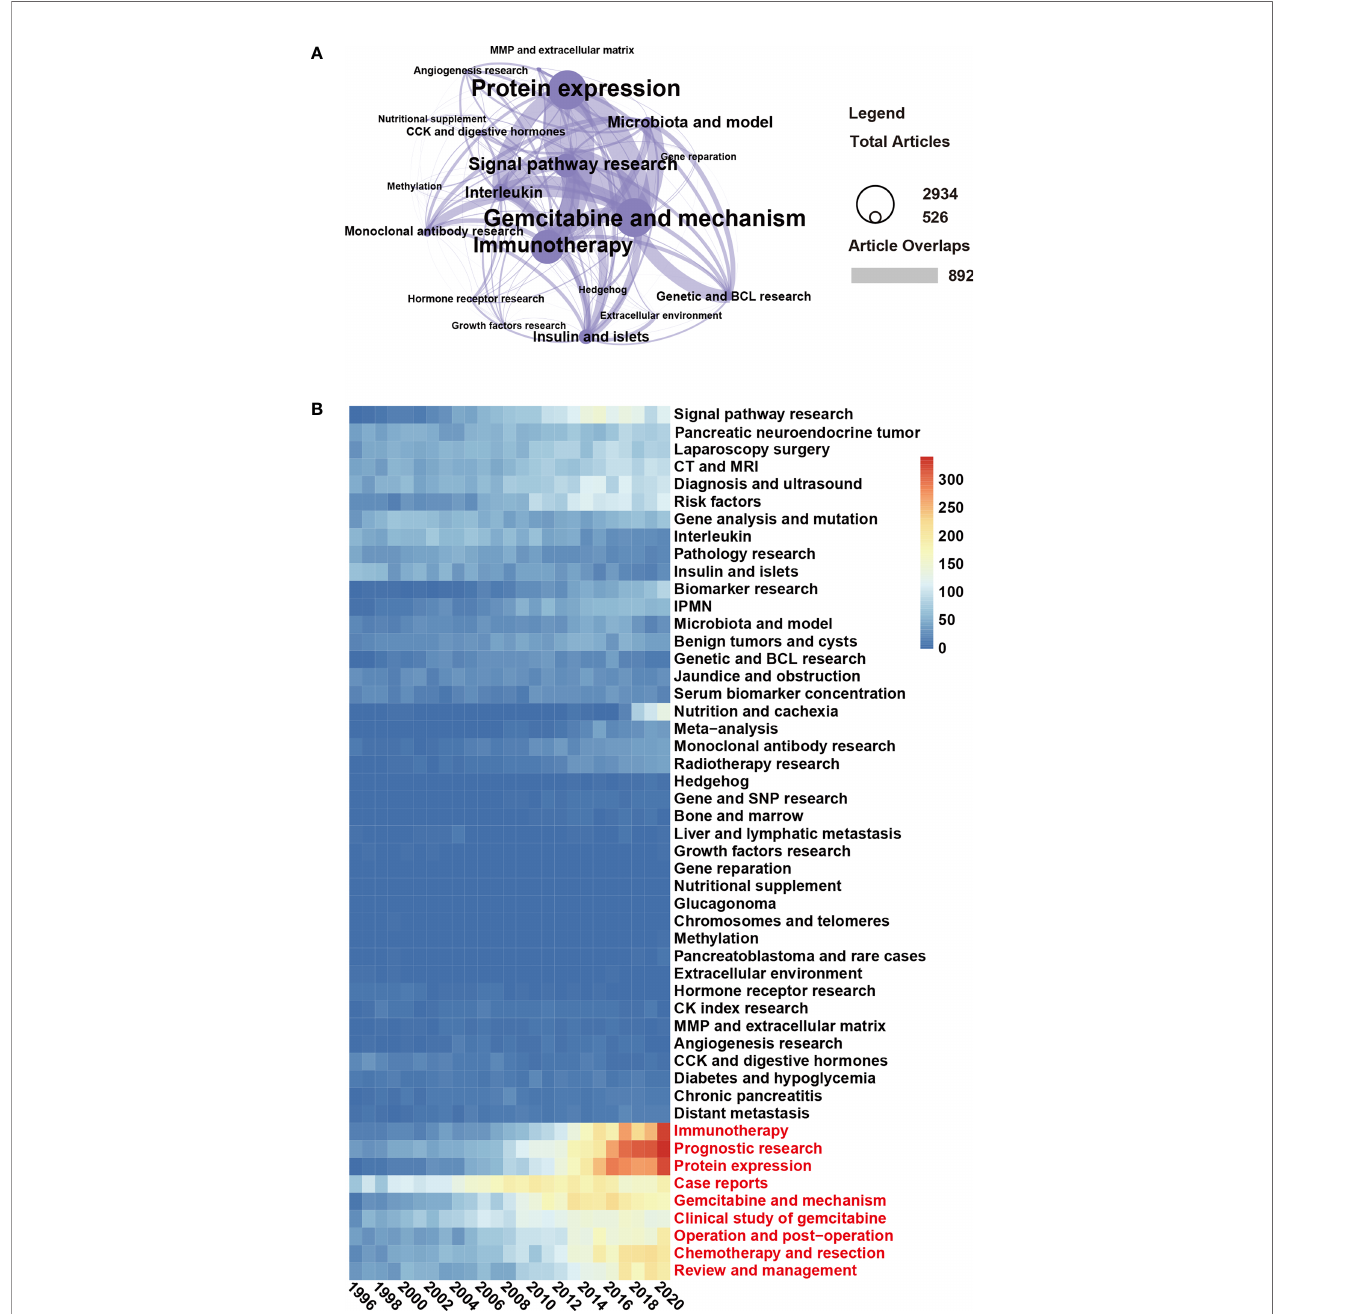
FIGURE 6 | “ Immunotherapy ” and “ Prognostic research ” are current research topics. (A) Topic cluster network of the topic “ Basic research ” and the interrelation of subtopics was analyzed using the LDA algorithm. In this cluster, the “ gemcitabine and mechanism ” topic included 2,934 publications, and 892 of these publications shared the same topic with the topic “ protein expression ” . (B) The heatmap presents the number of publications per year of 50 research topics over the past 25 years. The data were generated by the use of the LDA algorithm. The abscissa represents the year, the ordinate represents the topics, and the color brightness represents the number of publications and re fl ects the shift in research